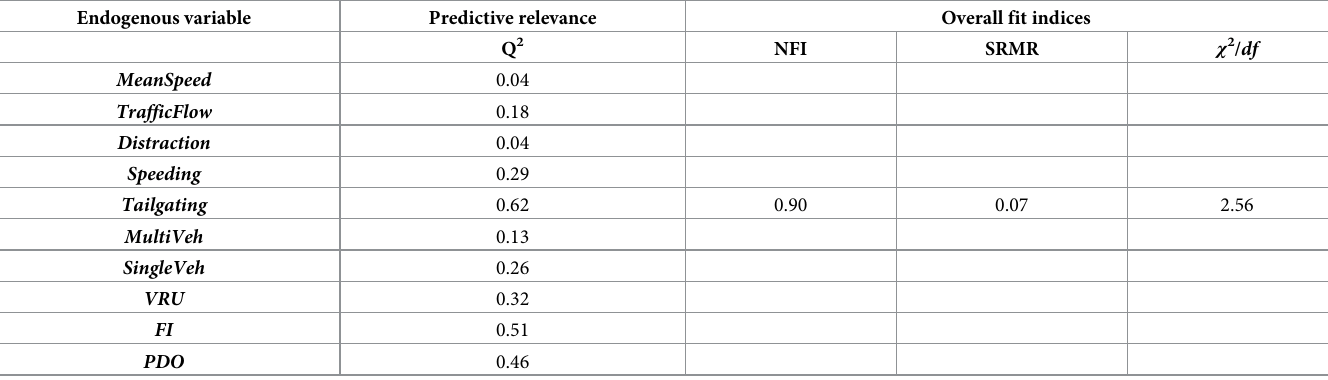
Table 3. The cross-validated predictive relevance and overall fit indices of the PLS path model.